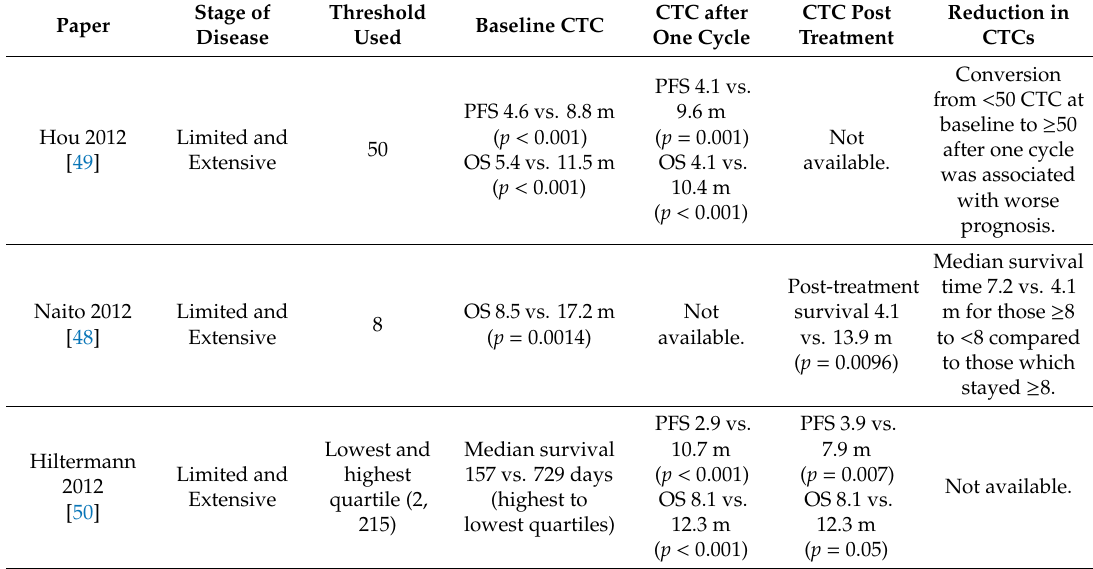
Table 2. Key findings from studies analysing the prognostic e ff ect of CTCs taken at baseline, after one cycle or completion of treatment, and change in CTC